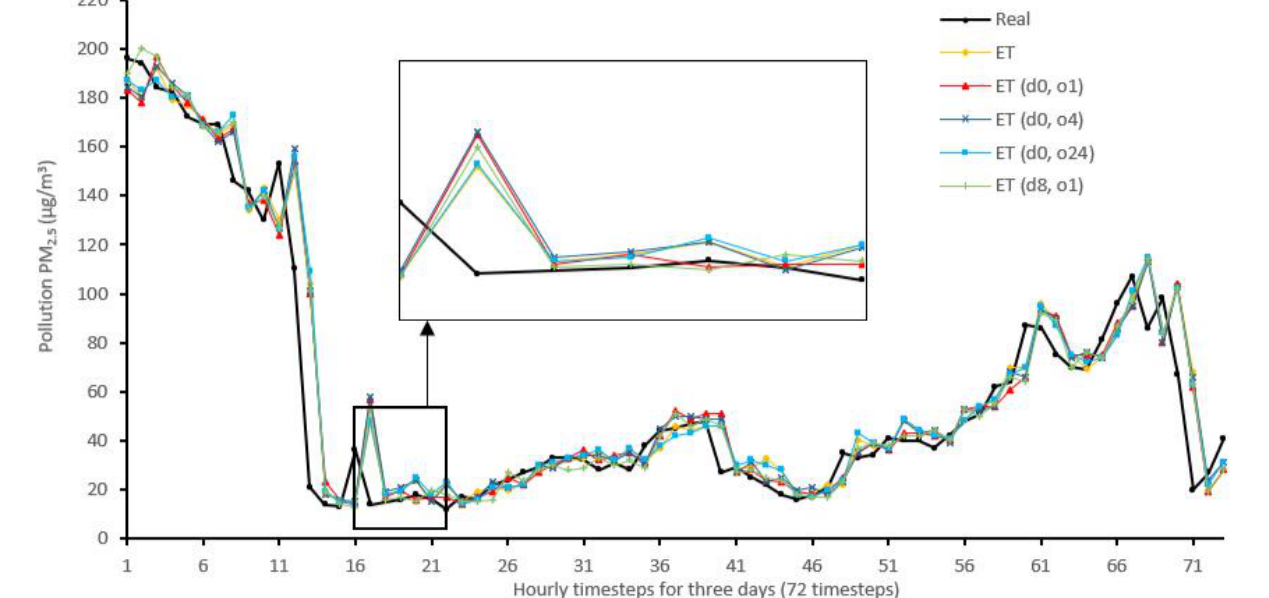
Figure 18. Real vs. Extra Trees and its NARX variants in part of the seventh iteration results for the Beijing dataset.